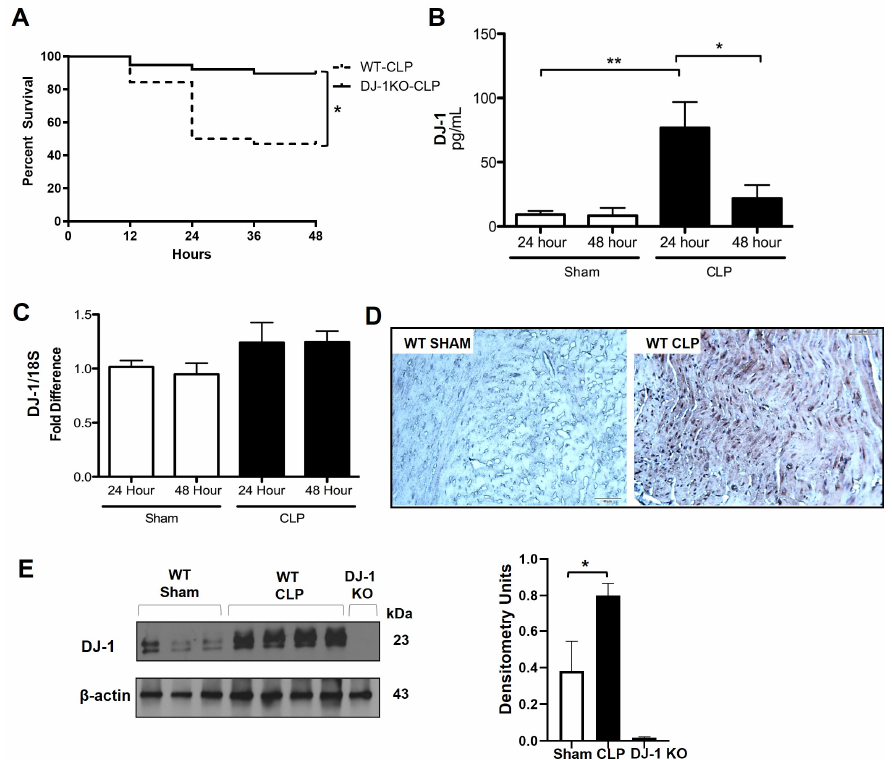
Figure 2. DJ-1 is increased in myocardium post-CLP. ( A ) Percent survival at 48 h post-CLP in WT and DJ-1KO ( n = 11). ( B ) Bars are mean + SEM of serum DJ-1 (ng/mL) of WT and DJ-1KO mice at 24 and 48 h post-CLP or sham operation. n = 11. ( C ) Bars are mean + SEM of DJ-1/18S mRNA expression in myocardium of WT and DJ-1KO mice at 24 and 48 h post-CLP or sham operation. n = 11. ( D ) Representative histology photomicrographs (×400) sections of formalin-fixed paraffin-embedded myocardial tissue from WT and DJ-1KO at 48 h post-CLP. Bar = 20µ. ( E ) Representative Western blot showing DJ-1 protein in myocardium from WT and DJ-1KO at 48 h post-CLP or sham operation. Densitometry units are shown. * p < 0.05; ** p < 0.01.